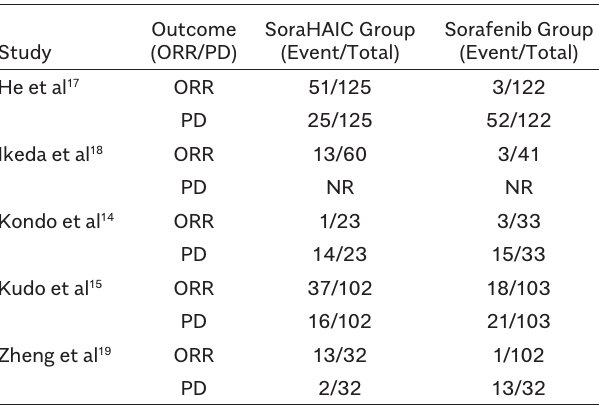
Table 4. The ORR and PD in Two Groups